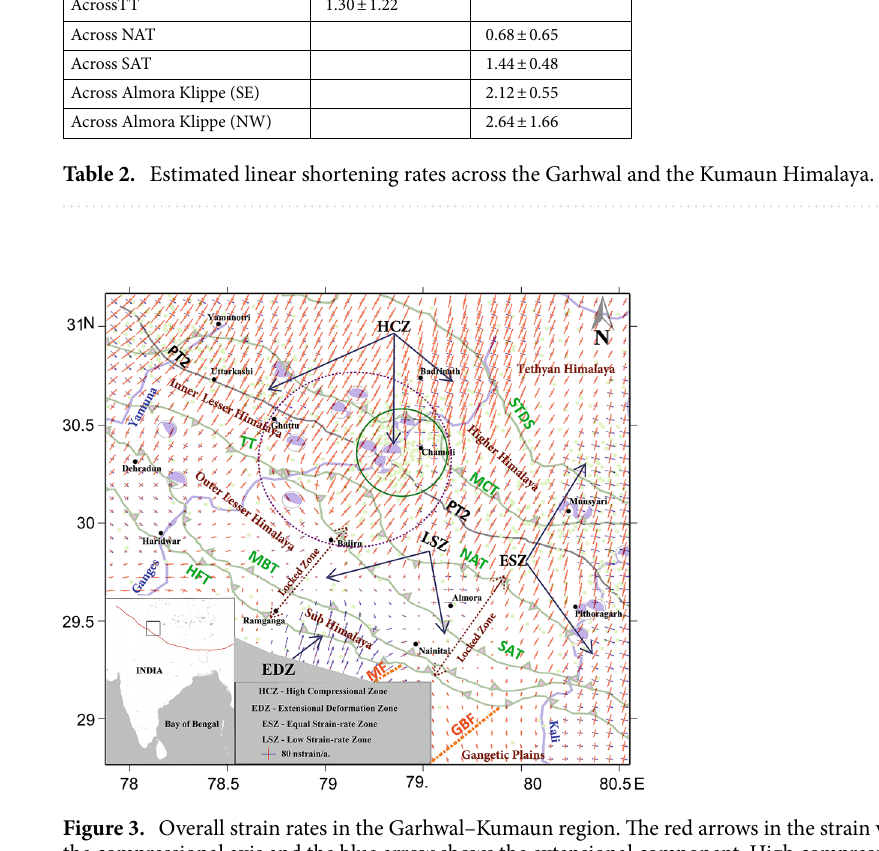
the northward movement and make complex deformation of the Kilppe. Low seismicity is observed across the Almora klippe which indicates that the region is locked and the local thrust system also adjusts accordingly. Surface strain‑rate analysis and the classification of different strain‑rate zones. The existence of varied surface accommodation rates in the study area poised us to look into the regional strain-rate pattern, seismicity, and the available fault plane solutions. Crustal strain rates in the study region were calculated from the GPS estimated crustal velocities based on the modified least square approach as explained by Teza et al. 34,35 . Details of the strain-rate calculations are given in the Data and Methodology section. Analysis shows the exist- ence of multifaceted strain-rate zones, where local and regional thrust systems have pivotal roles in regulating the overall regional seismicity distribution. Figure 3 explains the strain- rate vectors and we identified four types of surface deformation zones in the study area, namely (1) the High compressional zone (HCZ) -in the active seismic belt close to the MCT. (2) the Extensional deformation zone (EDZ) -mainly located in the Frontal Hima- laya adjoining to the transverse Moradabad Fault (MF) (3) the Equal strain-rate zone (ESZ), having nearly equal compressional and extensional components -mainly seen at the east of the river Kali and (4) the Low strain-rate zones (LSZ) -observed as isolated corridors in the Ramganga-Baijro and the Nainital-Almora region.